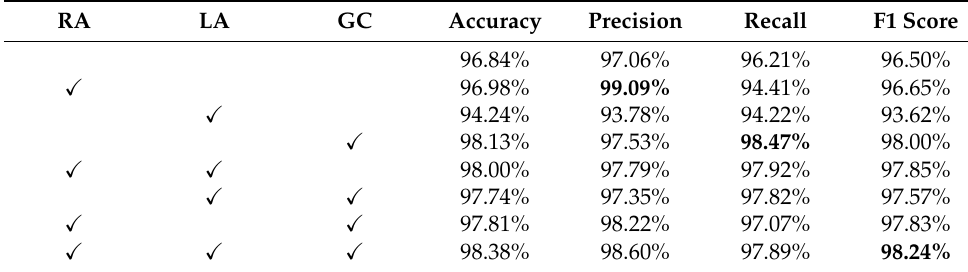
Table 3. Using training and optimization to begin the ablation study on LDCNN.